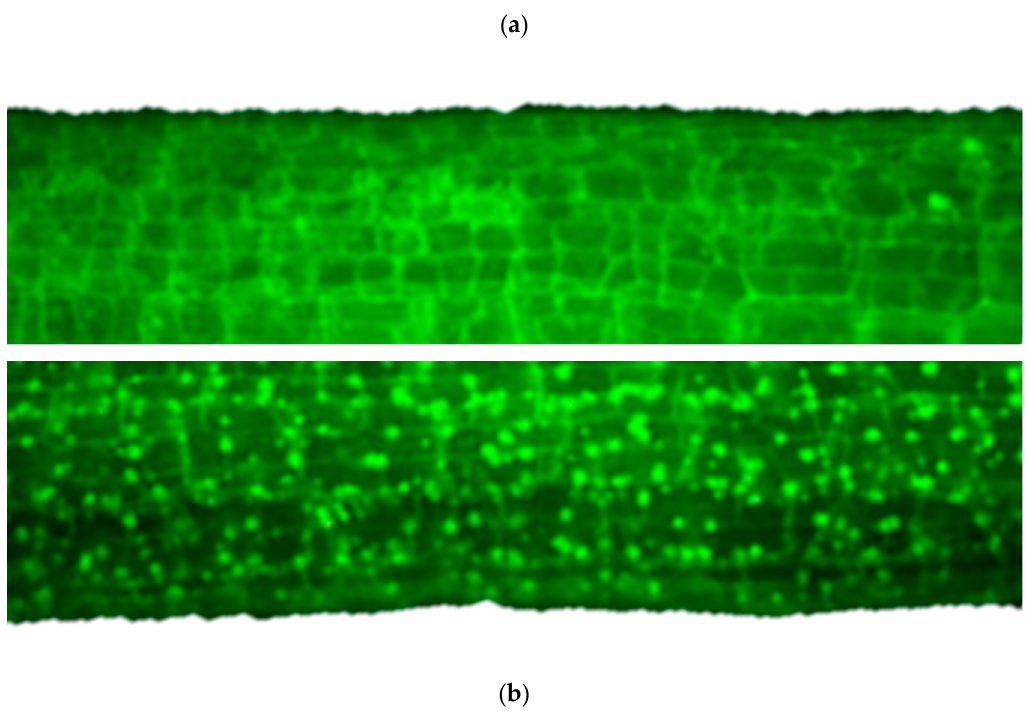
Figure 32. Fluorescence microscopic images of roots of ( a ) control and ( b ) treated Spirodela polyrhiza plant after four days of exposure to L -Cysteine-capped CdS NPs.(B) indicates the remarkable presence of nanoparticle aggregates inside the root tissues (modified after [149] ).